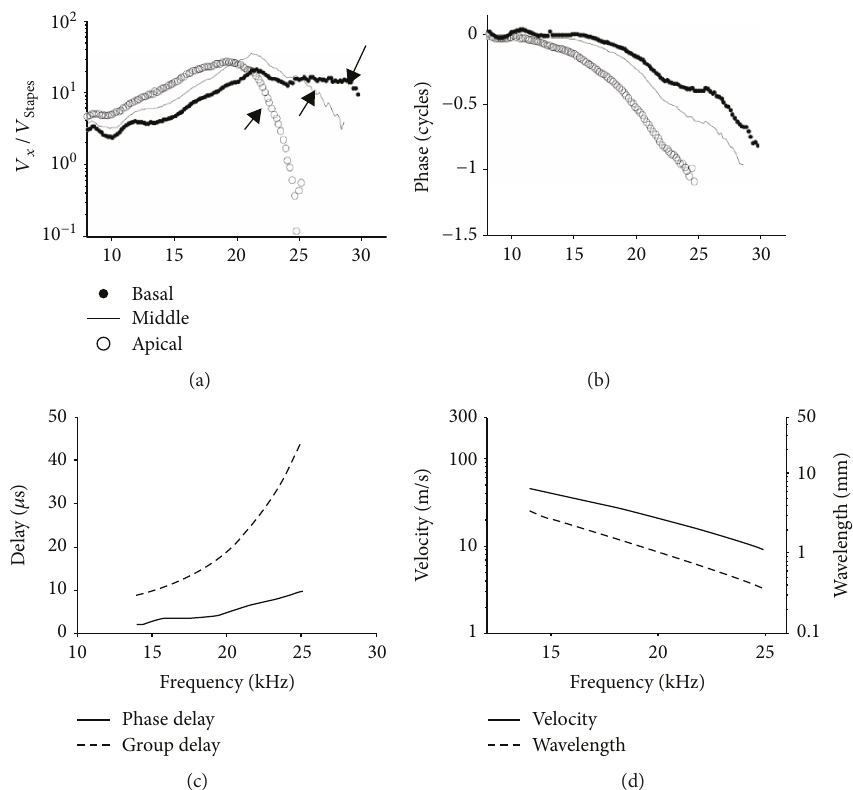
Figure 4: BM responses induced by normal acoustic stimulation at the ear drum. Vibration amplitude (a) and phase (b) of the beads on the BM. They are labeled as basal (dotted), middle (solid line), and apical (open cycle). Arrows in (a) indicates the roll-o ff of the amplitude responses. (c) Calculated phase and group delay between basal (dotted) and middle (solid line). (d) Calculated velocity (solid line) and wavelength (dashed